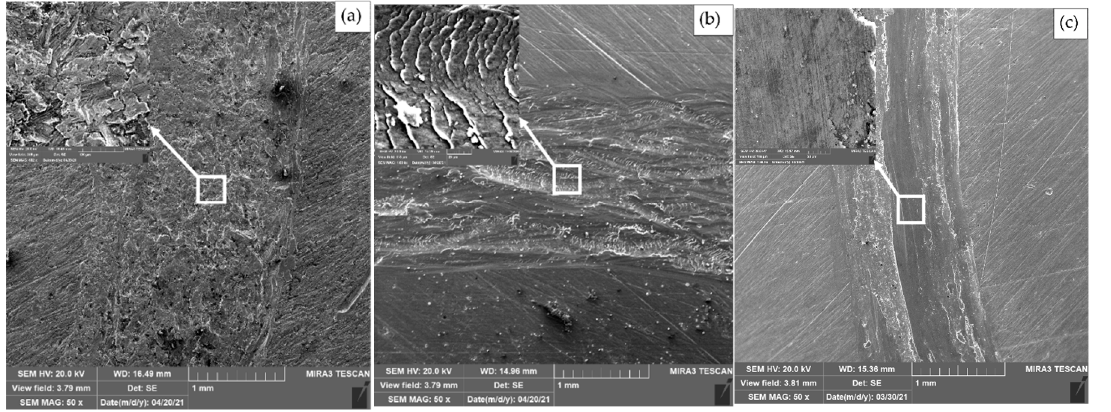
Figure 9. SEM images of the wear track of Al milled ( a ), Al-2%f.s ( b ), and 2%f.s-2%Cu ( c ) samples.